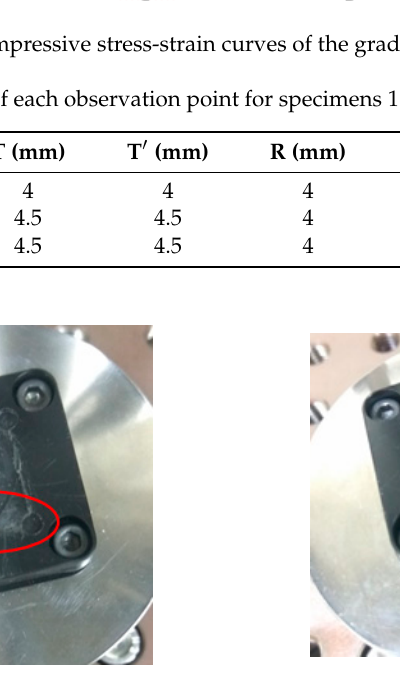
Figure 15. Scraps after the dynamic test.